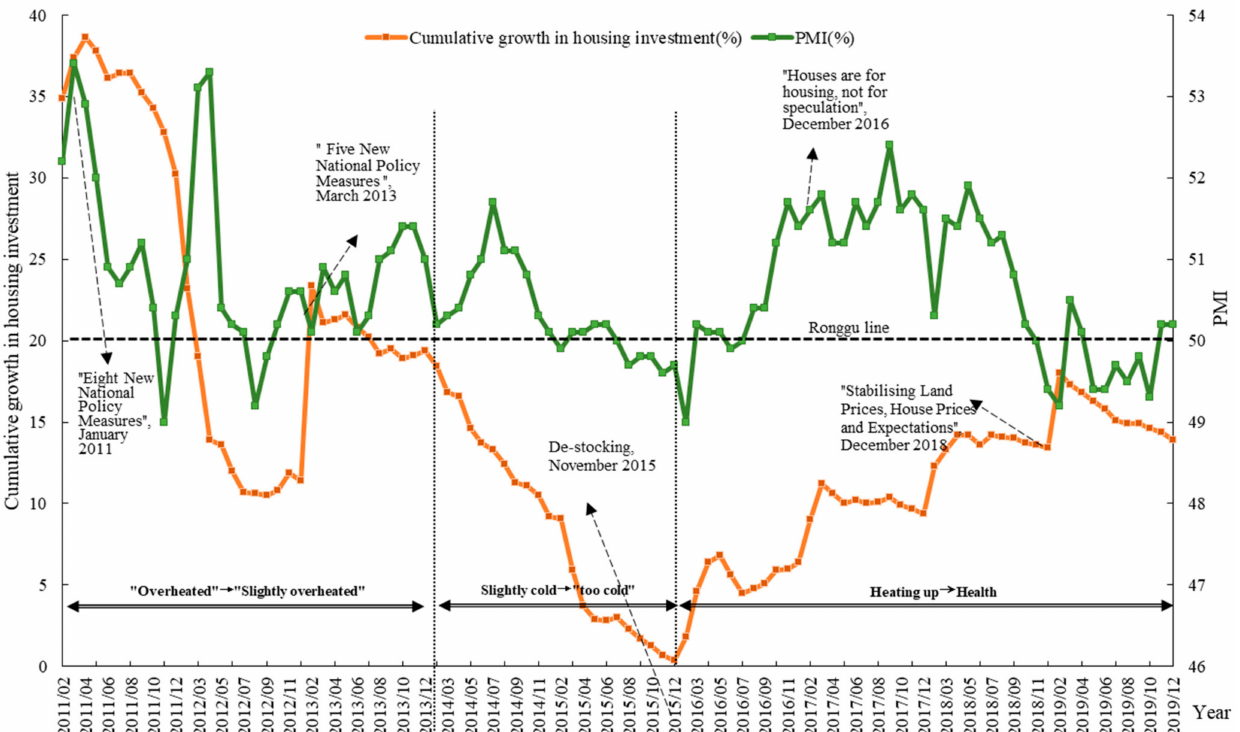
Figure 1. Cumulative growth rate of housing investment,